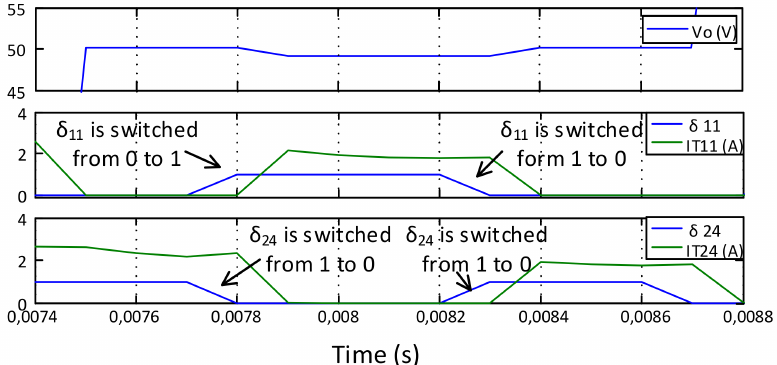
Figure 7. Output voltage V o (t), currents IT11 and IT24, and command of the switches T11 and T24 (Zoom 2).